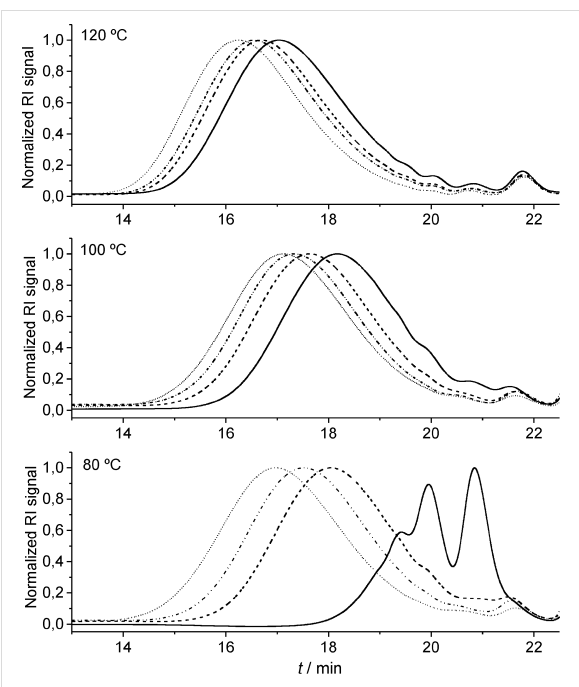
Figure 7: GPC traces of polymerizations performed with C1 at 80, 100, and 120 ºC. Samples taken at 5 min ( ― –), 15 min (–), 30 min (– • •), and 120 min (-).